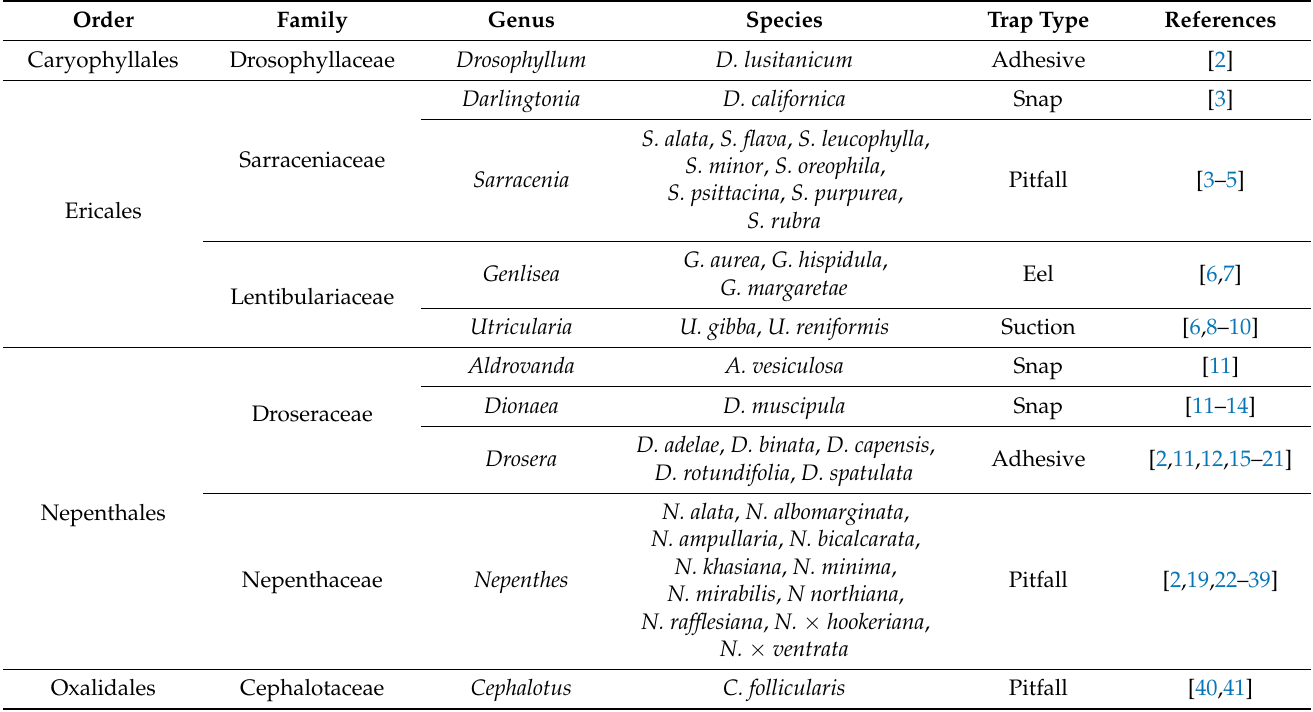
Table 1. The order, family, genus, and trap type of the carnivorous species discussed in this